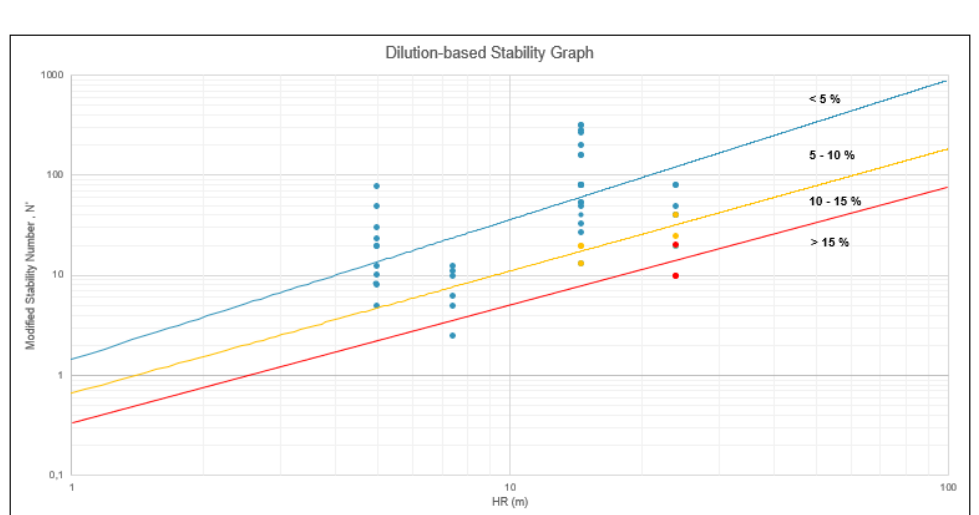
Figure 4. Proposed dilution-based stability graph approach .